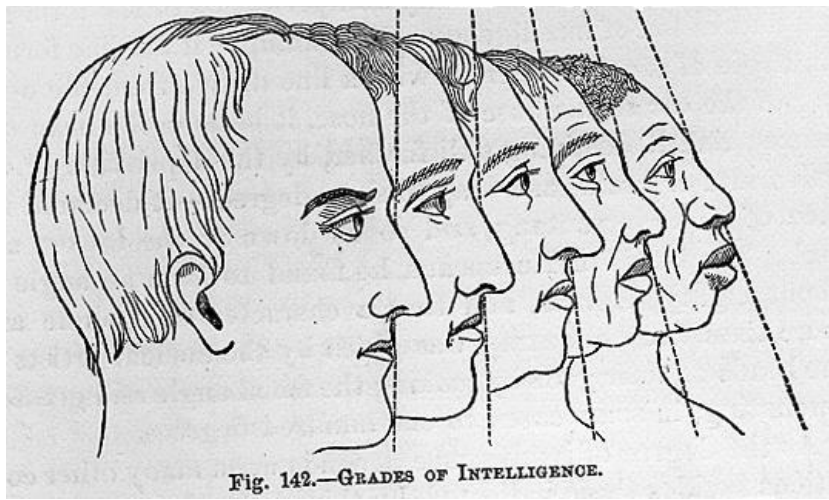
Figure 1. Samuel Wells, New Physiognomy